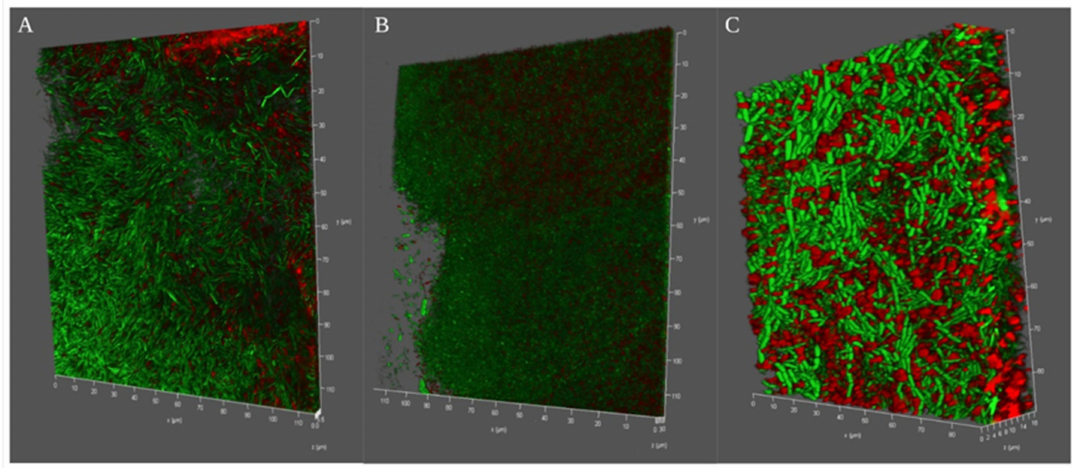
Figure 3. Confocal microscopy images of B. haynesii CamB6 competing against oxygen stress in different media and forming different depth of pellicles (Live–death images are shown in the green- or red-false-colored fluorescence channels merged); ( A ) NB medium, ( B ) LB medium, and ( C ) MB medium after 96 h of optimum pellicle